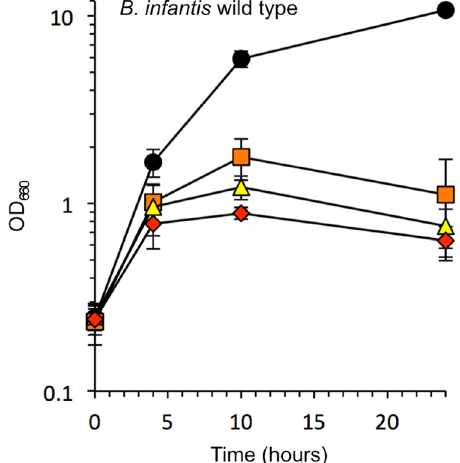
Figure 1. Growth of Bifidobacterium infantis JCM 1222 T in liquid shake culture at various O 2 concentrations. Circles, 100% N 2 cultures; squares, 5% O 2 /95% N 2 cultures; triangles, 10% O 2 /90% N 2 cultures; diamonds, 20% O 2 /80% N 2 cultures. Data represent the average ± SD of three independent